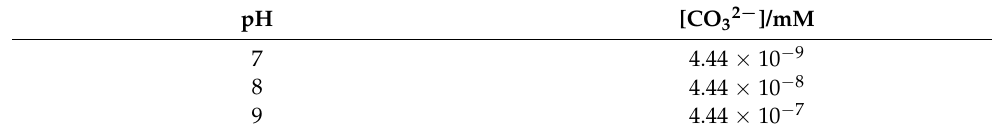
Table 1. Effect of pH on carbonate concentration at 9.5 mM bicarbonate solution.